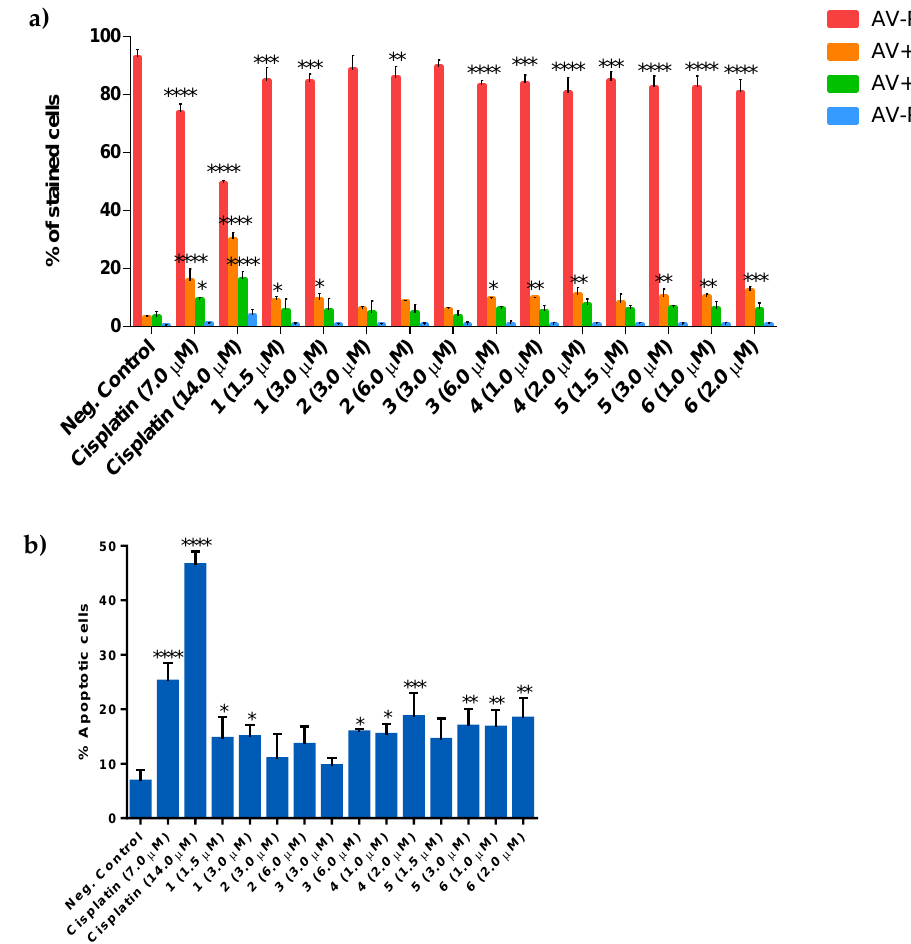
Figure 9. ‘FeCp’ compounds induce apoptosis in SW480 colorectal cancer-derived cell line. Apoptotic cell death was analyzed by Annexin V fluorescein isothiocyanate (AV-FITC) and propidium iodide (PI) assay in SW480 cells, after incubation with IC 50 and 2 × IC 50 concentrations for 48 h. ( a ) Analysis of AV / PI assay in SW480 cells. Values represent mean ± S.D. of at least three independent experiments. Statistical analysis was performed by two-way ANOVA with Dunnett’s multiple comparisons test. ( b ) Graphical representation of the total percentage of apoptotic cells (early apoptosis (AV + PI − ) and late apoptosis (AV + PI + )). Statistical analysis was performed by one-way ANOVA with Dunnett’s multiple comparisons test. * P ≤ 0.05; ** P ≤ 0.01; *** P ≤ 0.001; **** P ≤ 0.0001 when compared with the negative control.